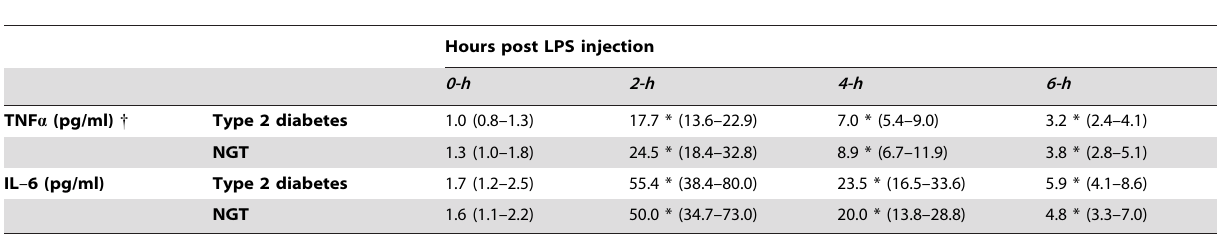
Table 2. Plasma cytokines, glucose and free fatty acids before and after LPS